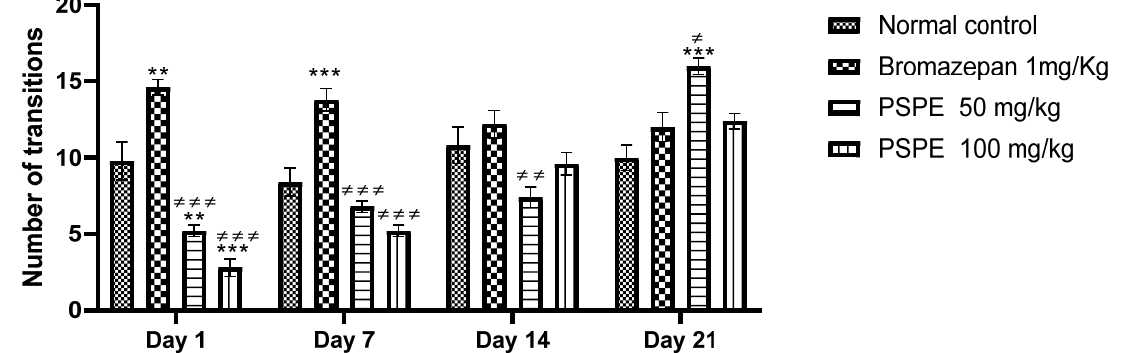
Figure 6. Variation in time spent in the lighted chamber during the three weeks of treatment in control and treated mice (*** p ≤ 0.001 in comparison to negative controls, ≠≠ p ≤ 0.01 and ≠≠≠ p ≤ 0.001 in comparison to positive controls). PSPE: Polyphenolic fraction of P. sativum.